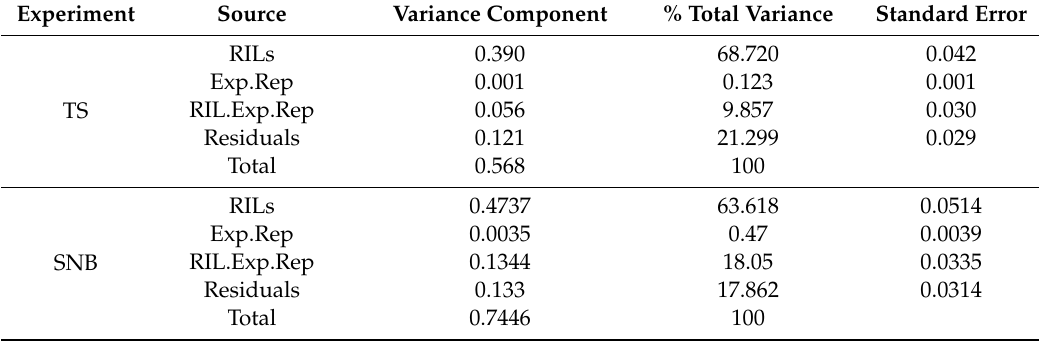
Table 2. Variance components of TS and SNB in 204 RILs of the PBW343 / Kenya Nyangumi